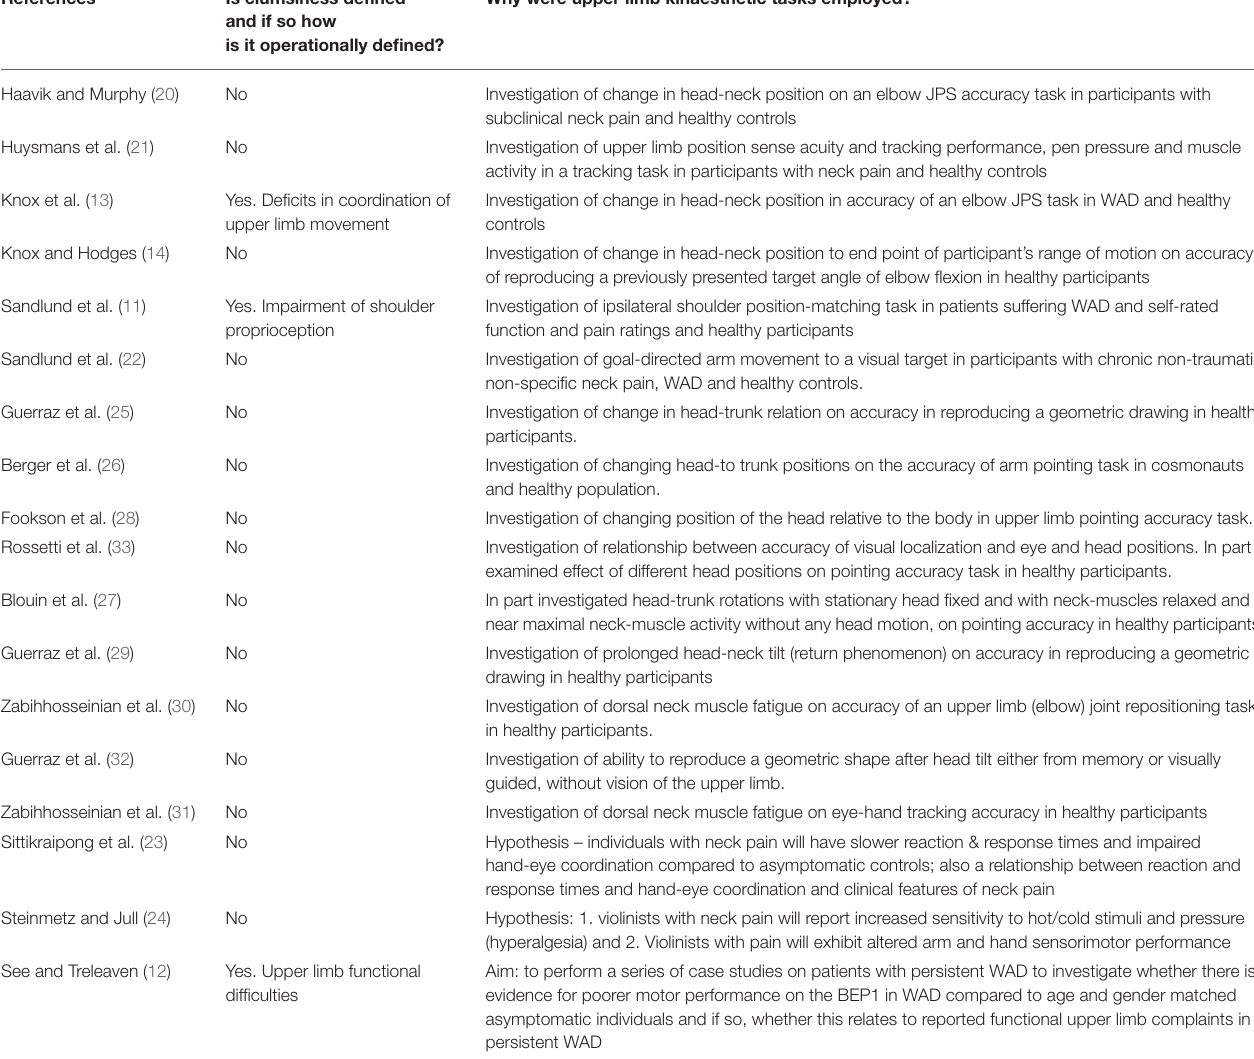
TABLE 3 | Definitions of clumsiness and investigations of performance of upper limb kinesthestic